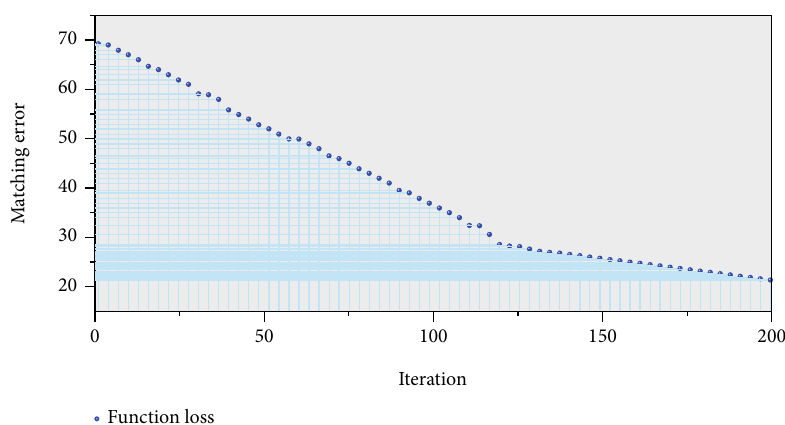
Figure 4: Network model training iteration error